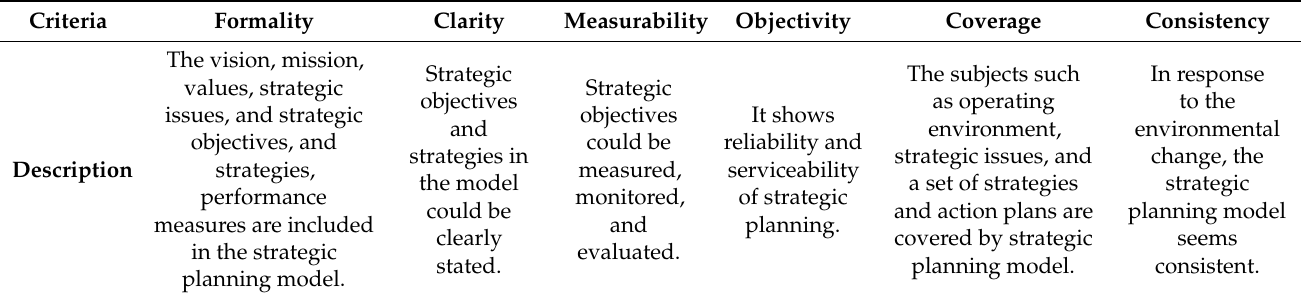
Table 1. Description of criteria.